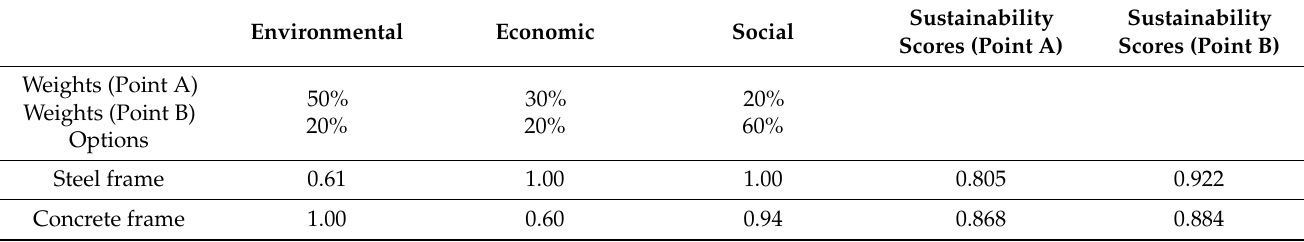
Table 8. Sustainability scores of alternatives (in terms of load) for weighting scheme of points A and B in Figure